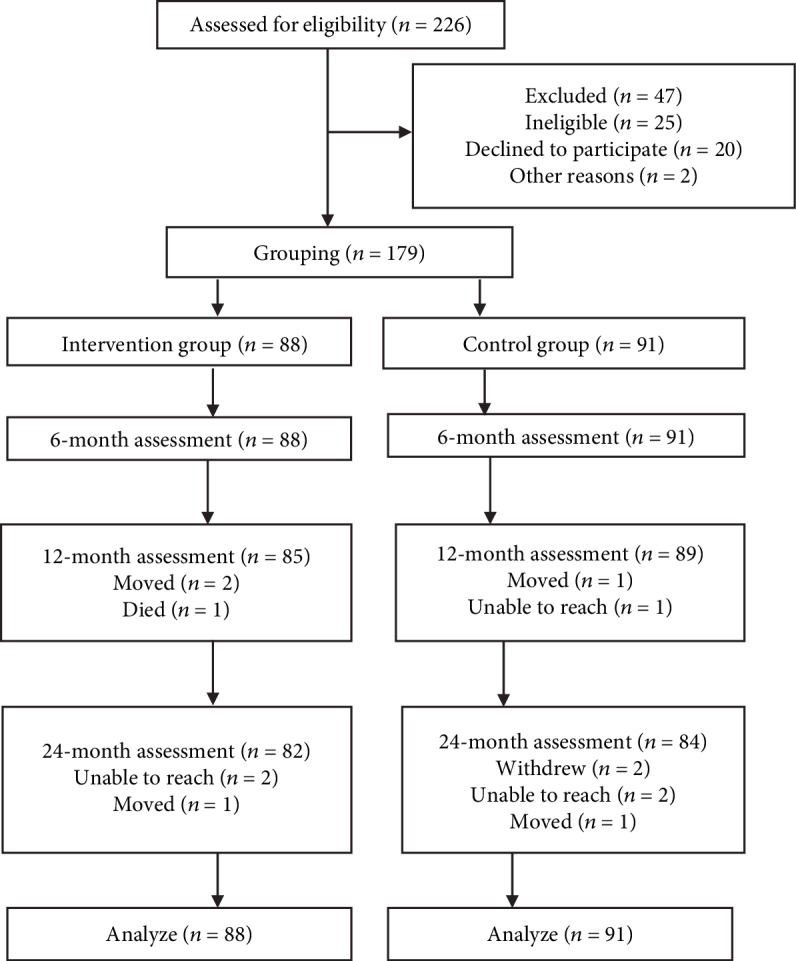
Flow diagram of participants through each stage of the trial.